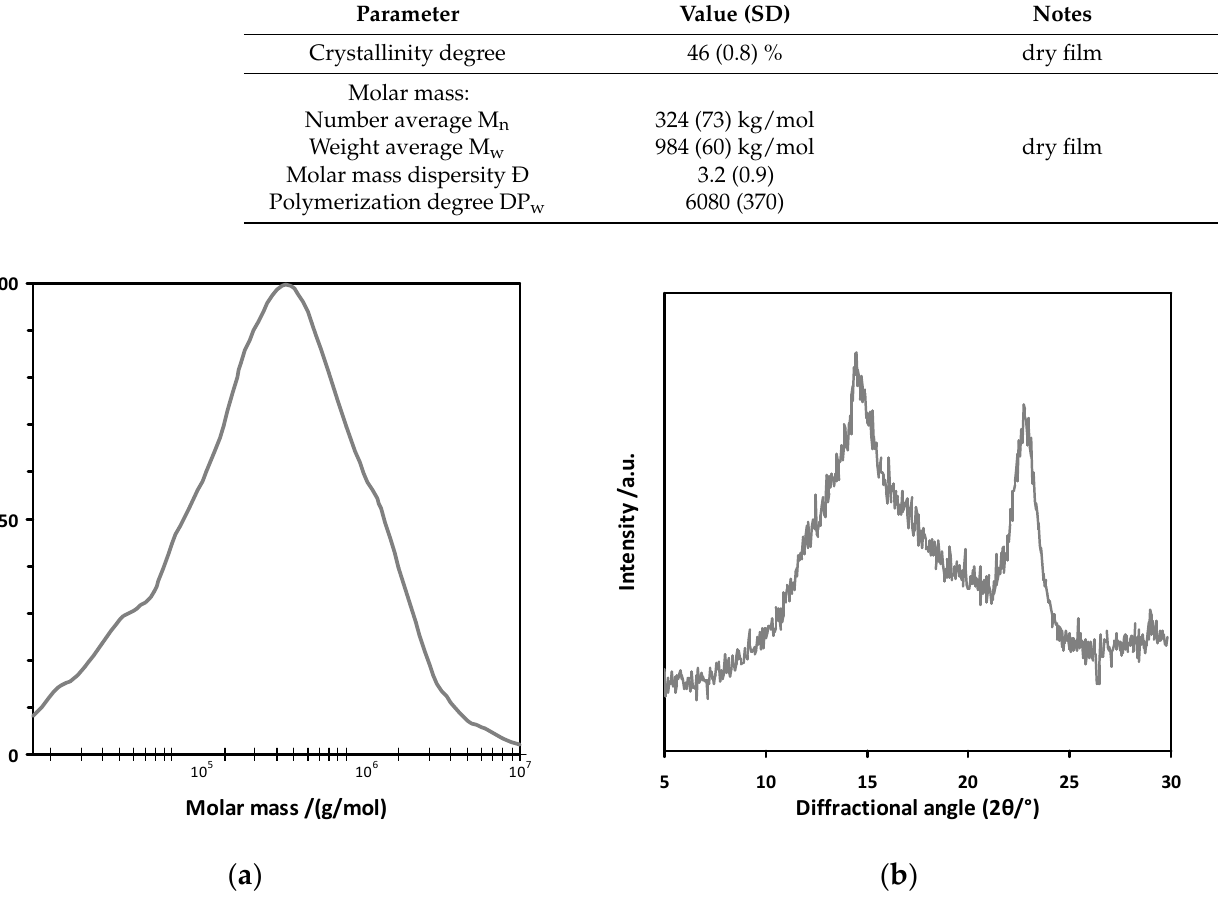
Figure 1. The raw bacterial cellulose properties: ( a ) molar mass distribution; ( b ) XRD curve for crystallinity determination. Table 1. Properties of the raw bacterial cellulose film.